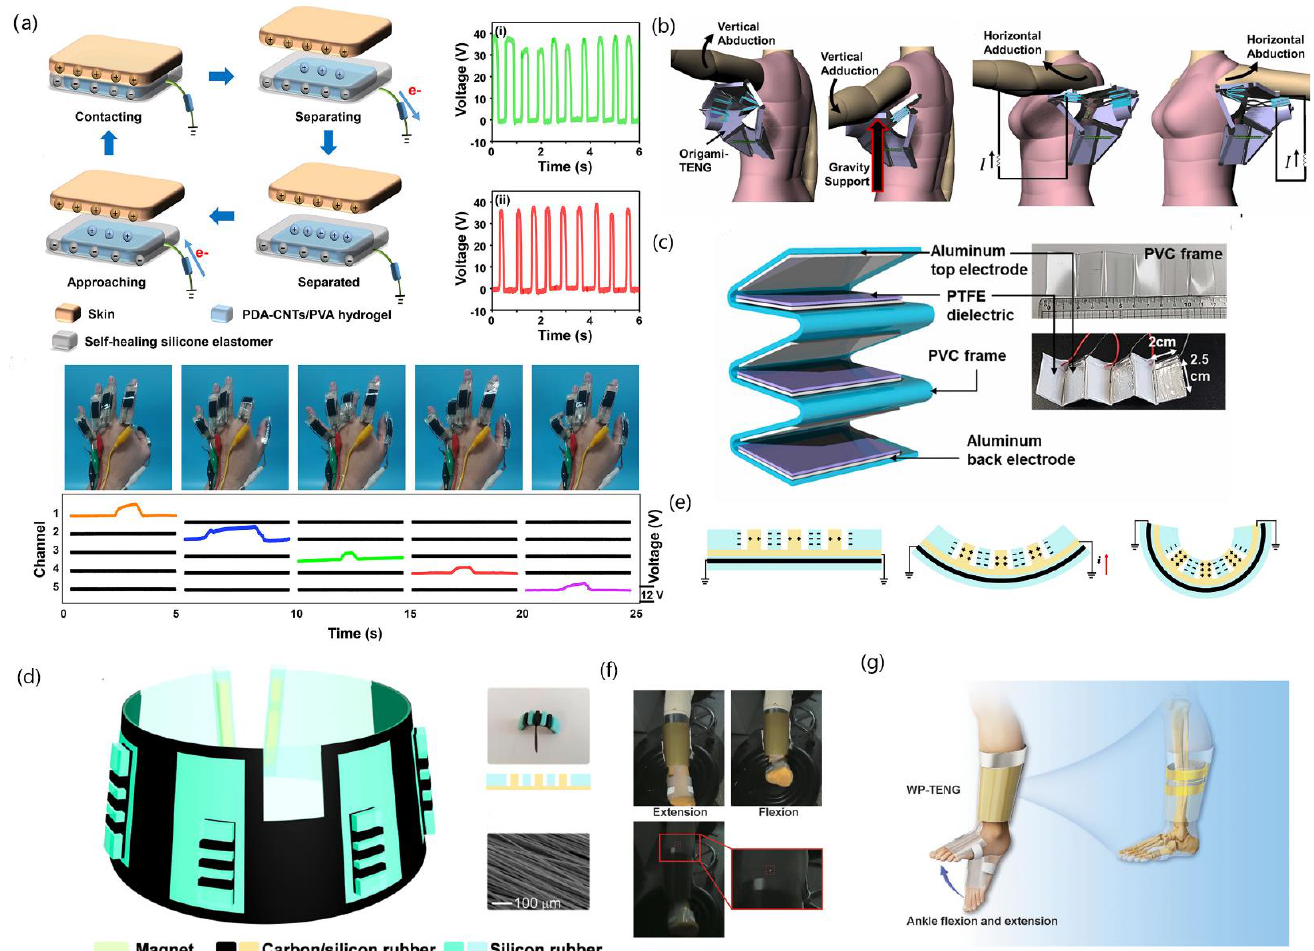
Figure 7. Application of TENG in human rehabilitation. ( a ) Schematic illustration of the working mechanism of the MF-TENG in single-electrode mode; Open-circuit voltage of ( i ) the original and ( ii ) the self-healed MF-TENG; Real-time responses of the bending of fingers acquired via five channels made of the MF-TENG [72]; Copyright 2021, American Chemical Society. ( b ) Schematic showing vertical shoulder adduction-abduction motion with Origami-TENG and Schematic showing horizontal shoulder adduction-abduction motion with Origami-TENG [75]; ( c ) Schematic and photograph of the TENG and its components [75]; Copyright 2022, Elsevier Ltd. ( d ) Schematic structure of the SNM-TS; Photograph of the S-TENG with a carbon fiber line (above) and schematic structure of the S-TENG (below); SEM image of the carbon fiber line [76]; ( e ) Schematics of the operating principle of the S-TENG [76]; Copyright 2022, American Chemical Society. ( f ) WP-TENG is activated by the human limb movement; human ankle flexion and extension drive WP-TENG to form electric flow [78]; ( g ) Schematic illustration of WP-TENG activated by human limb movement [78]; Copyright 2022, Wiley-VCH.